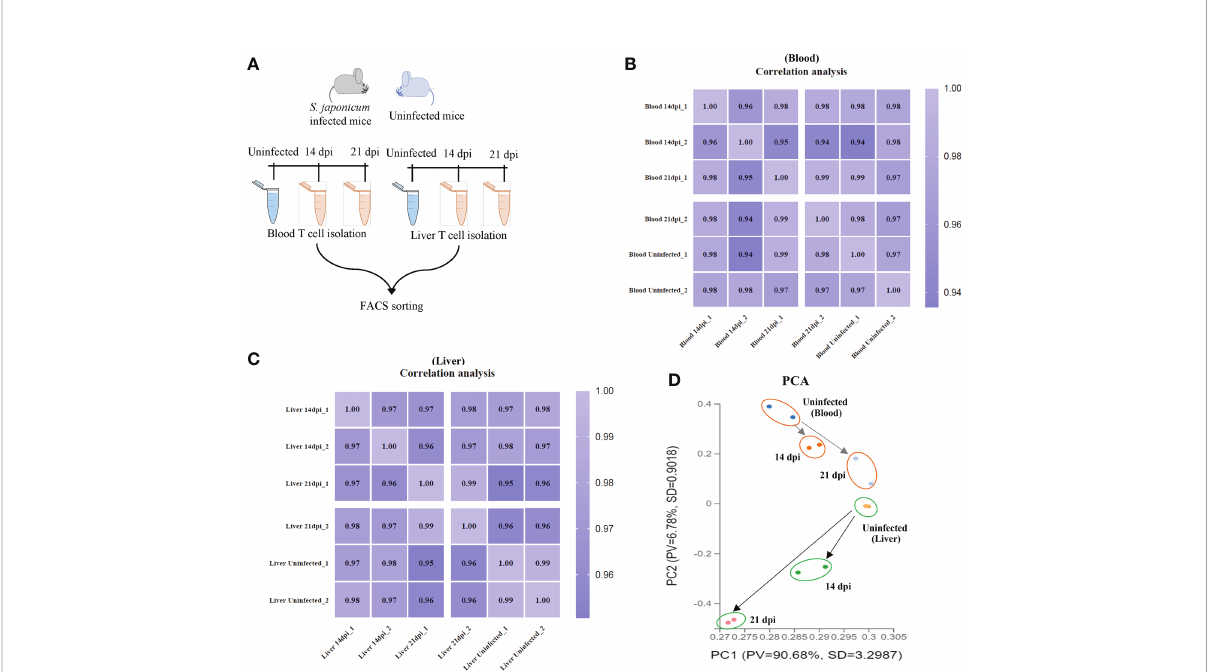
FIGURE 1 T cell isolation and RNA seq analyses. (A) Schematic work fl ow for T cell isolation at different stages of S. japonicum infected mice and uninfected mice; (B, C) Heatmap of Pearson correlations of T cell miRNA expressions among different samples from blood (B) and liver (C) at different stages of S. japonicum infected mice and uninfected mice. Colors in the heat map indicate the Pearson correlation coef fi cient among different samples, lighter color indicated higher correlation; (D) PCA analyses of T cell samples isolated from blood and liver of S. japonicum infected mice at 14 dpi and 21 dpi and uninfected